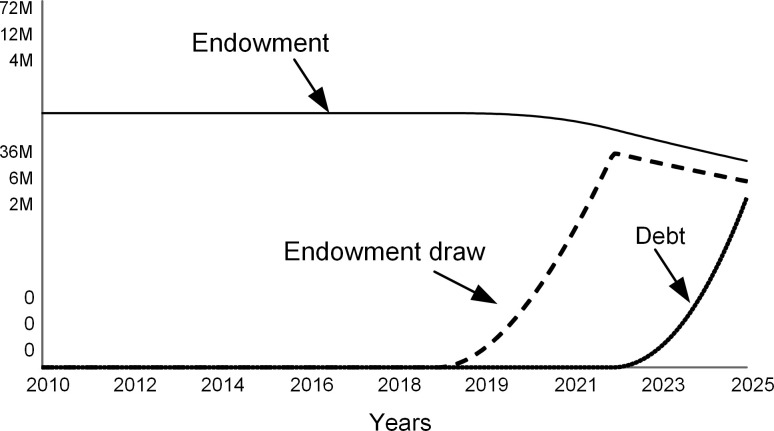
Endowment and debt.